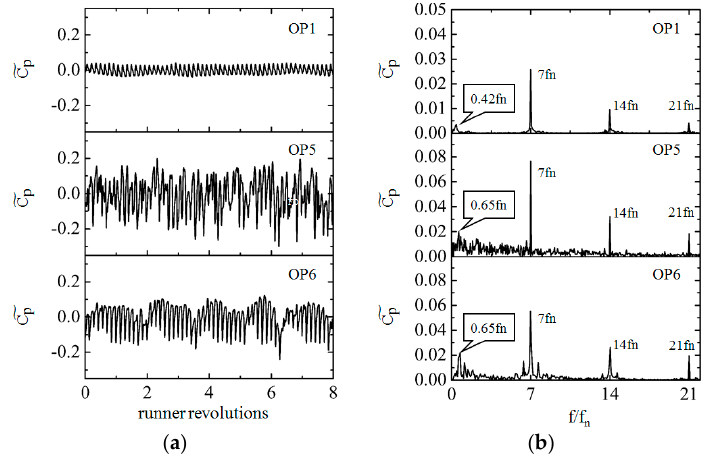
Figure 11. Measurements at monitor GV5. ( a ) Pressure fluctuations; and ( b ) frequency spectra.